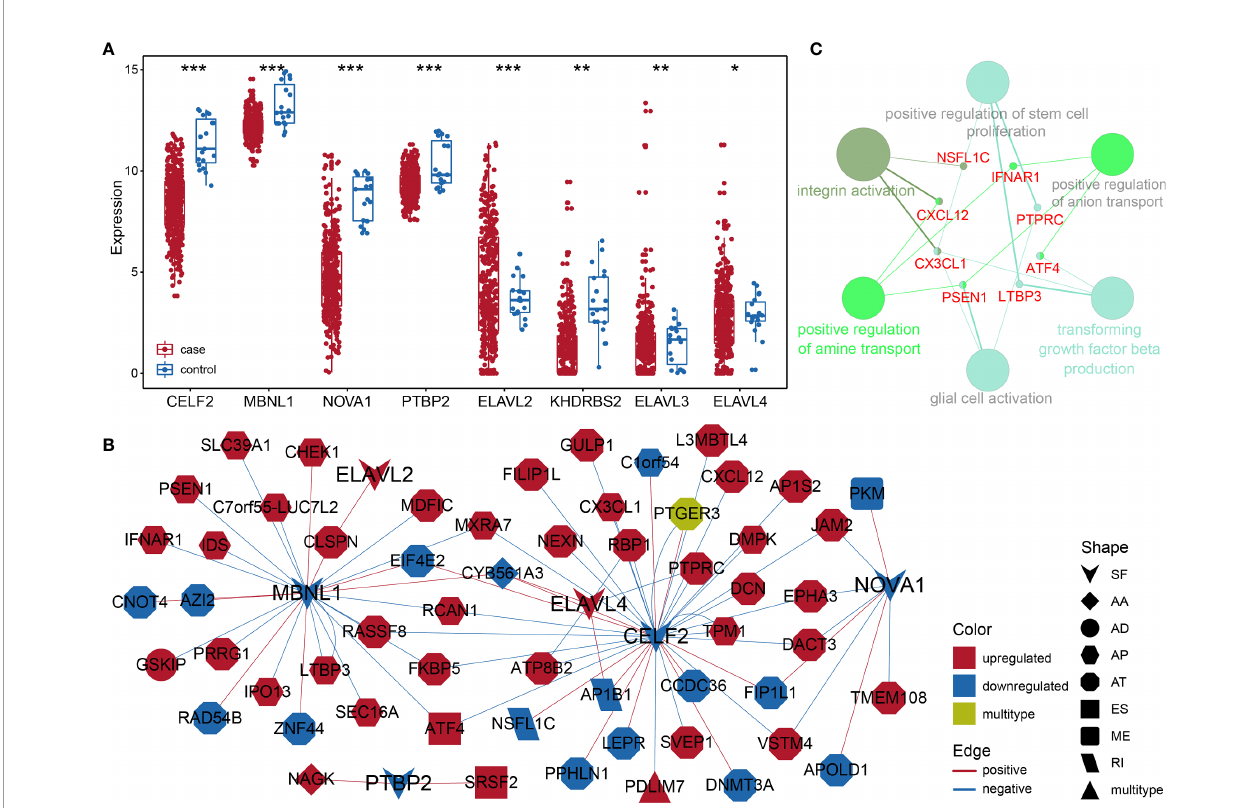
FIGURE 6 | (A) Box plot of differentially expressed SFs in BLCA. (B) Different AS networks in BLCA. (C) Gene-rich GO terms in different AS networks in BLCA. * represents p values< 0.05, ** represents p values < 0.01, *** represents p values<